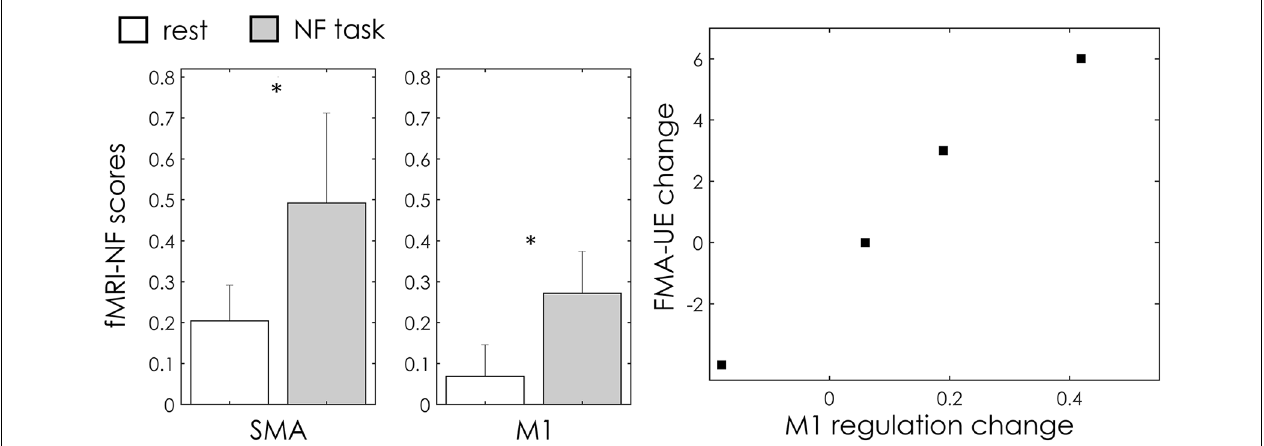
FIGURE 3 | Group results. (A) fMRI NF scores values (mean ± standard error across subjects and NF runs) with relative statistics; ∗ indicates statistically significant difference ( p < 0.01) between rest and NF task as assessed with a Wilcoxon test across subjects. (B) Scatter plot relating change in the clinical outcome (FMA-UE score) and ipsilesional M1 BOLD regulation for the four